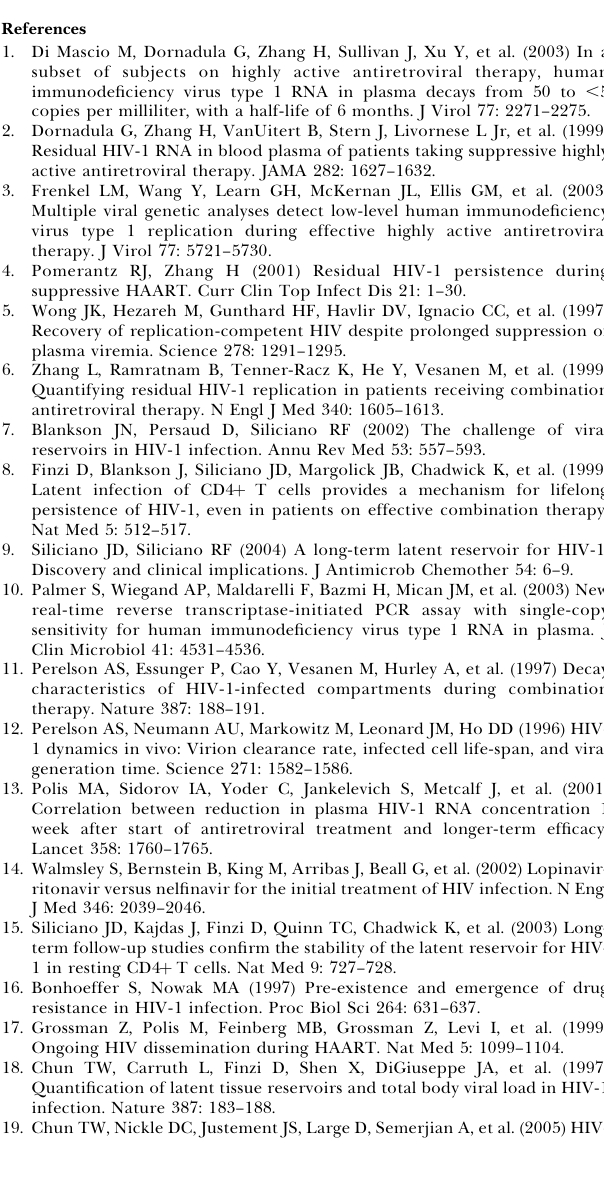
Figure S1. Schematic Describing Patient Inclusion for Study of HIV-1 Viremia in M98–863 Patients Found at doi:10.1371/journal.ppat.0030046.sg001 (21 KB DOC). Figure S2. Correlation between Pretherapy Plasma HIV-1 RNA Levels as Determined by Amplicor HIV-1 Monitor Assay and SCA Pretherapy samples from 157 participants were analyzed by both assays. 12 samples (triangles) had SCA values significantly lower than Amplicor and were excluded from further analysis. Remaining samples ( n ¼ 145, diamonds) were highly correlated ( r 2 ¼ 0.61,